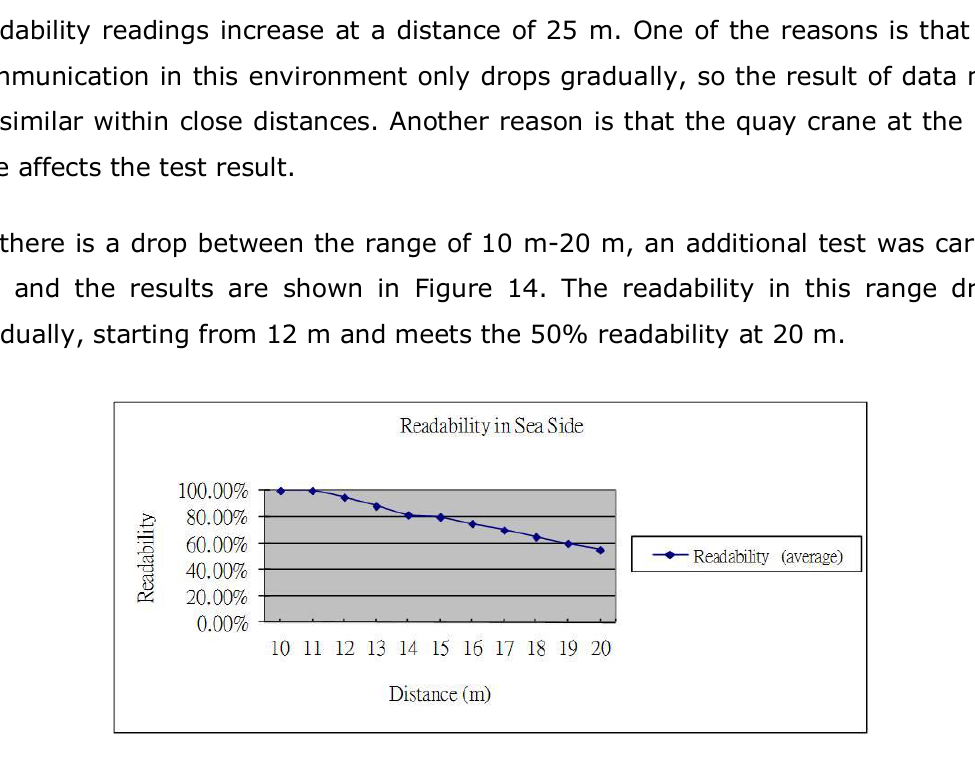
Figure 14. Relationship between readability and distance in Sea Side